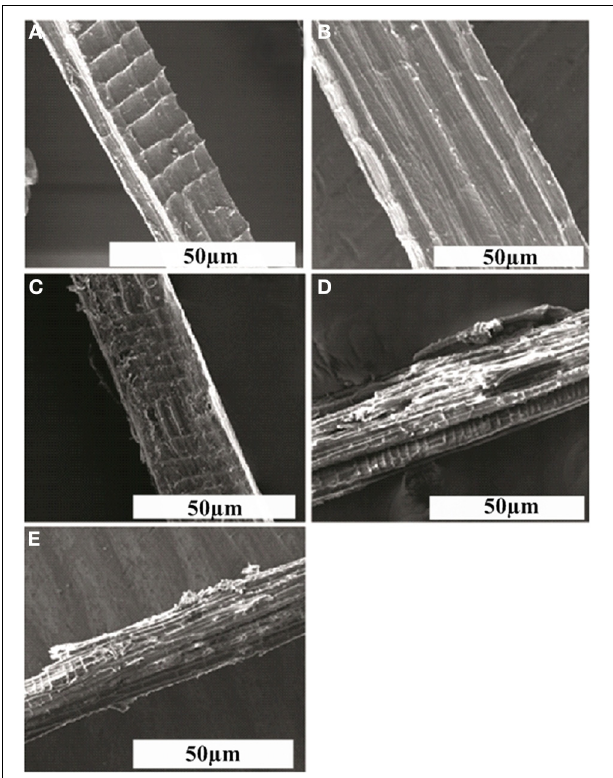
Figure 3 | Scanning electron micrographs of (A) raw Grewia optiva fibre, (B) delignified Grewia optiva fibre, (C) dGo-g-poly(MMA), (D) d Go -g-poly(MMA-co-EMA), and (E) d Go -g-poly(MMA-co-EA).